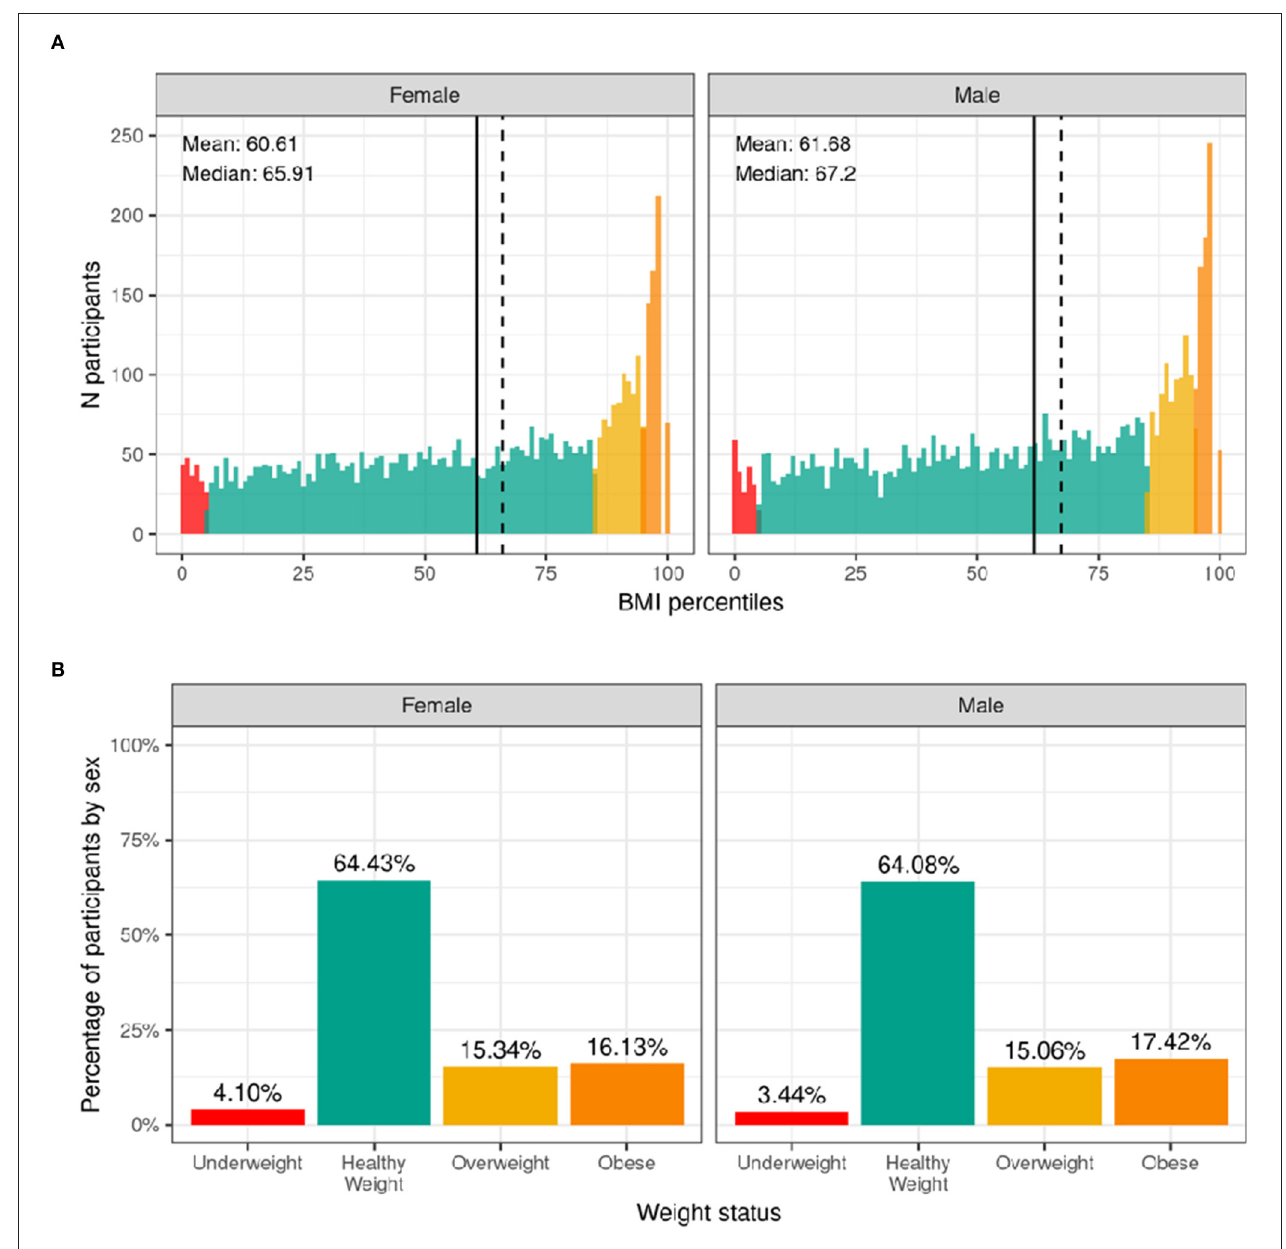
FIGURE 9 | Distribution of BMI and weight status in the ABCD sample. (A) Continuous distribution of BMI percentiles stratified by sex assigned at birth color coded based on weight status: underweight (red), healthy weight (green), overweight (yellow) and obesity (orange). (B) Percentage of participants (stratified by sex assigned at birth) within each weight